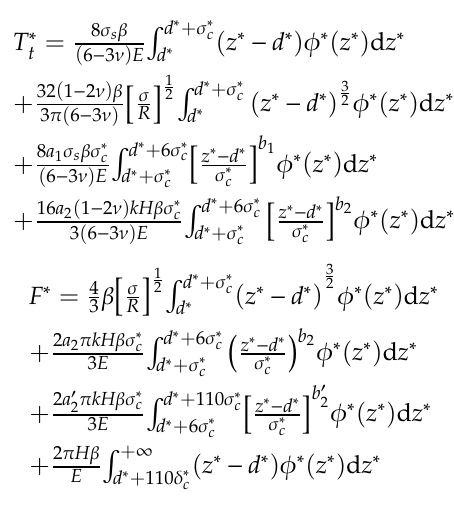
Figure 11. Grouting clamp structure.